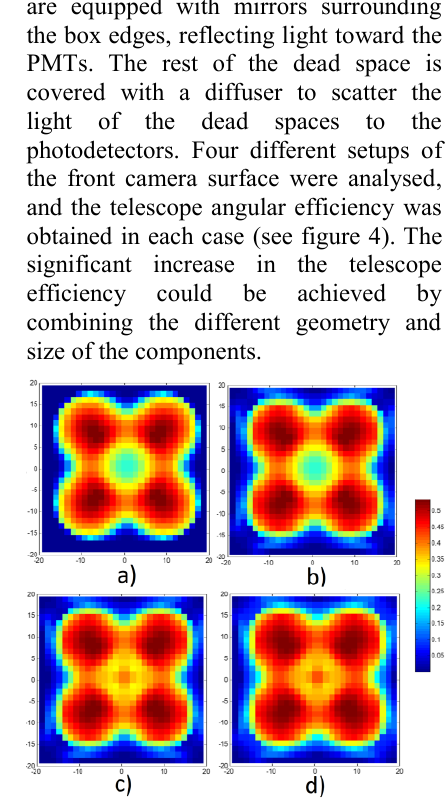
Fig. 4. FAST angular efficiency distribution for four different camera layouts as a function of the azimuth and elevation angle. The results can be interpreted by two numbers, the average FoV efficiency (for all elev. and azimuth angles) and the efficiency for the on- axis ray (0, 0 deg). X-axis represents the azimuth and Y-axis the elevation angles of the incident light. The colour scale is normalized between 0 – 1. An efficiency of 1 corresponds to the aperture input power. a) camera box only - 40.2%/25.0%, b) camera box with side mirrors - 41.2%/25.2%, c) camera box with side mirrors and central pyramid - 42.0%/40.2% and d) camera box with side mirrors, central pyramid and camera front panel diffuser -